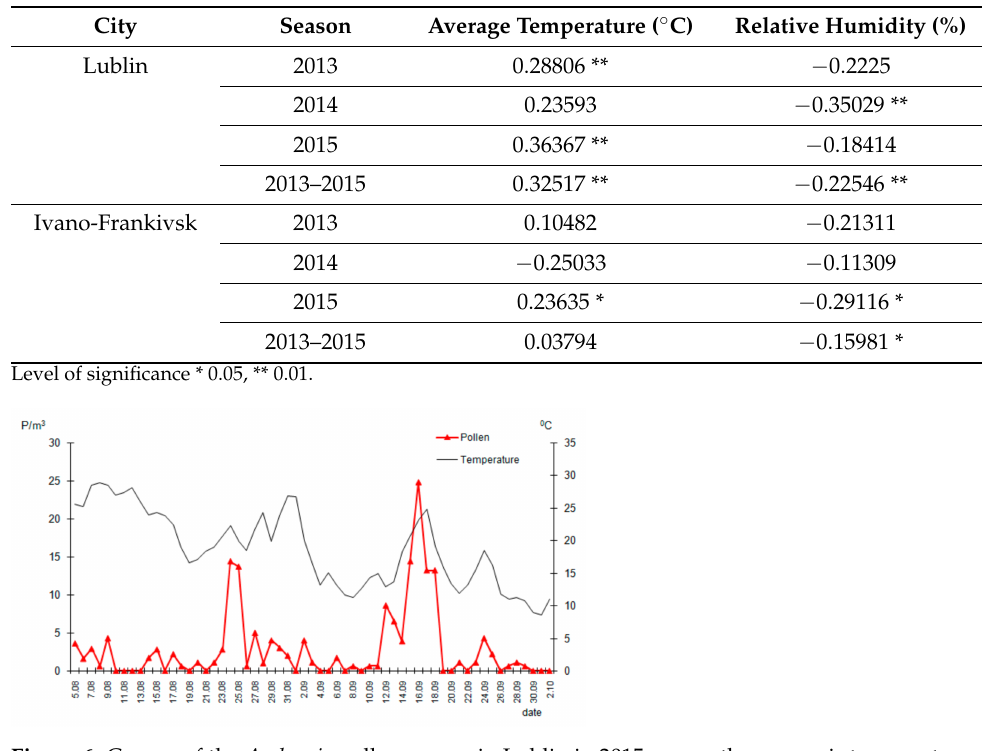
Table 2. Spearman’s correlation coefficients between Ambrosia pollen concentration and meteorologi- cal factors in Lublin (Poland) and Ivano-Frankivsk (Ukraine).